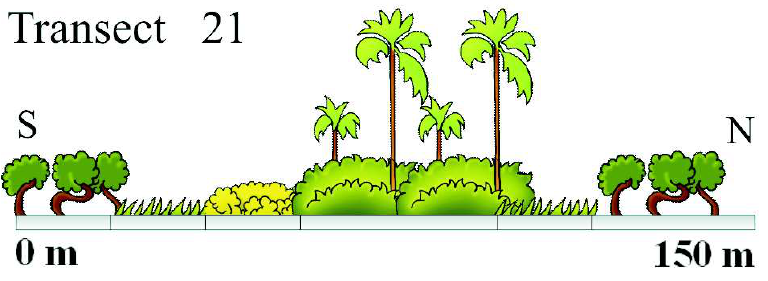
Figure 4. Example of graphically enhanced transect across a narrow stretch of vereda . Note the buriti palms in the center, bordered by shrub, grasses and wooded savanna